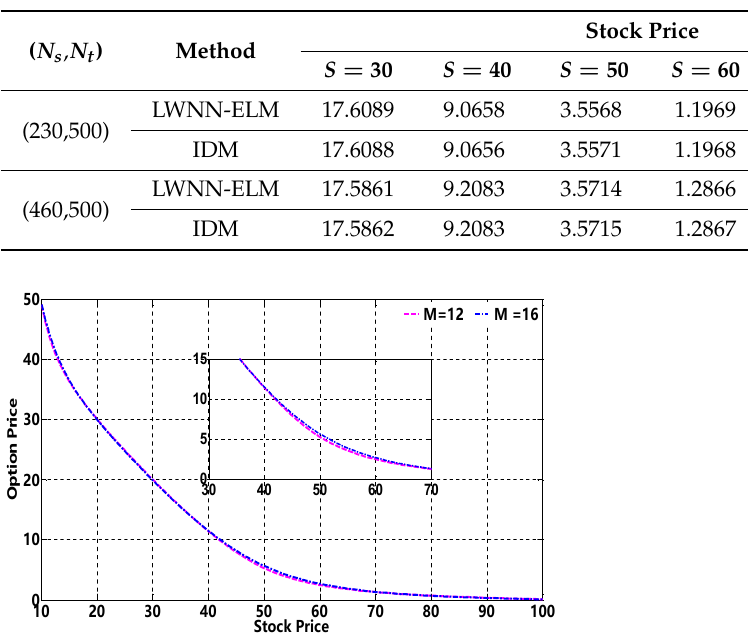
Table 3. The numerical solutions of the European put option, where the corresponding parameters are K = 50, T = 1, r = 0.01, σ = 0.1, A = 10, B = 100, and M = 16.